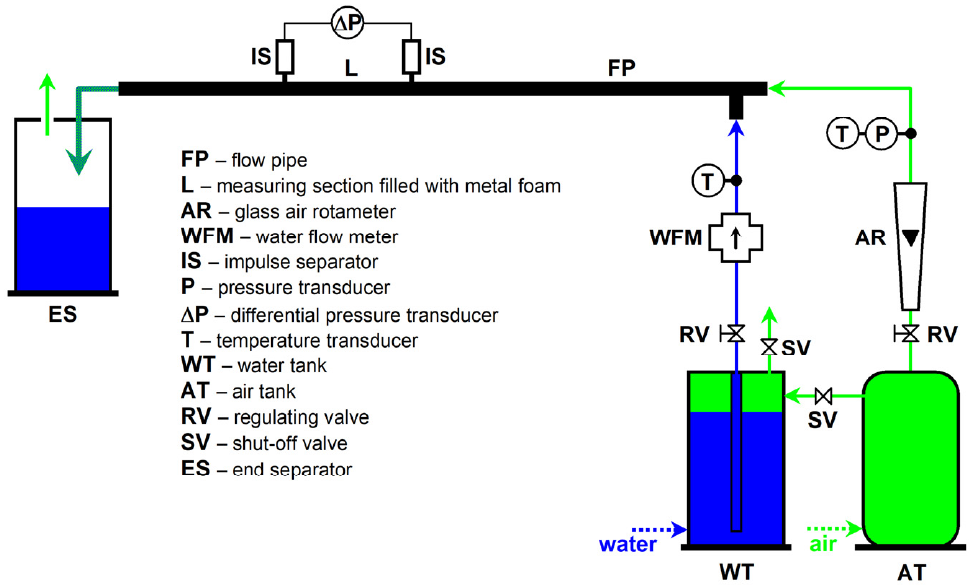
Figure 3. Scheme of the measuring setup. Compressed air and tap water formed the components of the two-phase mixture flow. Pressurized air and water tanks AT and WT , respectively, were periodically filled with air and water, and in order to degas water, its tank was initially left open to be drained. The drainage of water from the tank was induced by the pressure of the air that was also pumped into the flow pipe FP . The solution adopted in this manner had two advantages. The first one was designed to achieve identical temperatures of both fluids, since